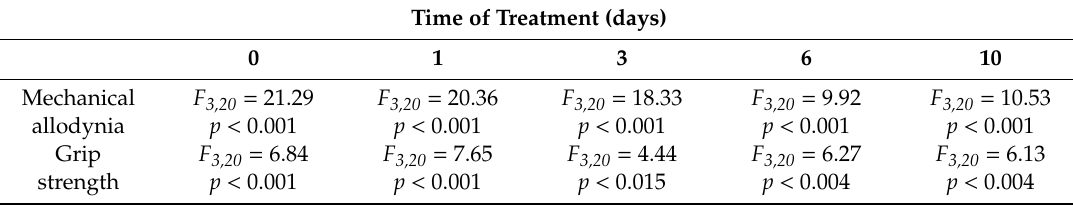
Table 2. Summary of the one-way ANOVA’s performed with the results obtained for the mechanical allodynia and grip strength deficits at 0, 1, 3, 6, and 10 days after the administration of P-ITC or vehicle in SS and MIA-injected